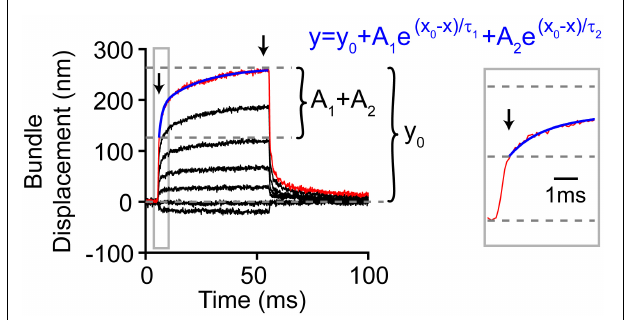
FIGURE 9 | Analysis method for hair bundle creep. Red line highlights the measured motion for the largest step, and blue indicates the double exponential fit (equation in blue) to the creep (gray box zooms in on the onset). Not all the bundle motion was included in the blue fit as shown. The zoom-in view shows the part of the onset that was not included in the fit. During this time, the force stimulus itself was still rising and reached a plateau 0.5 ms after force onset. Thus, the creep kinetics were fit after this. Arrows indicate the time points between which the creep was